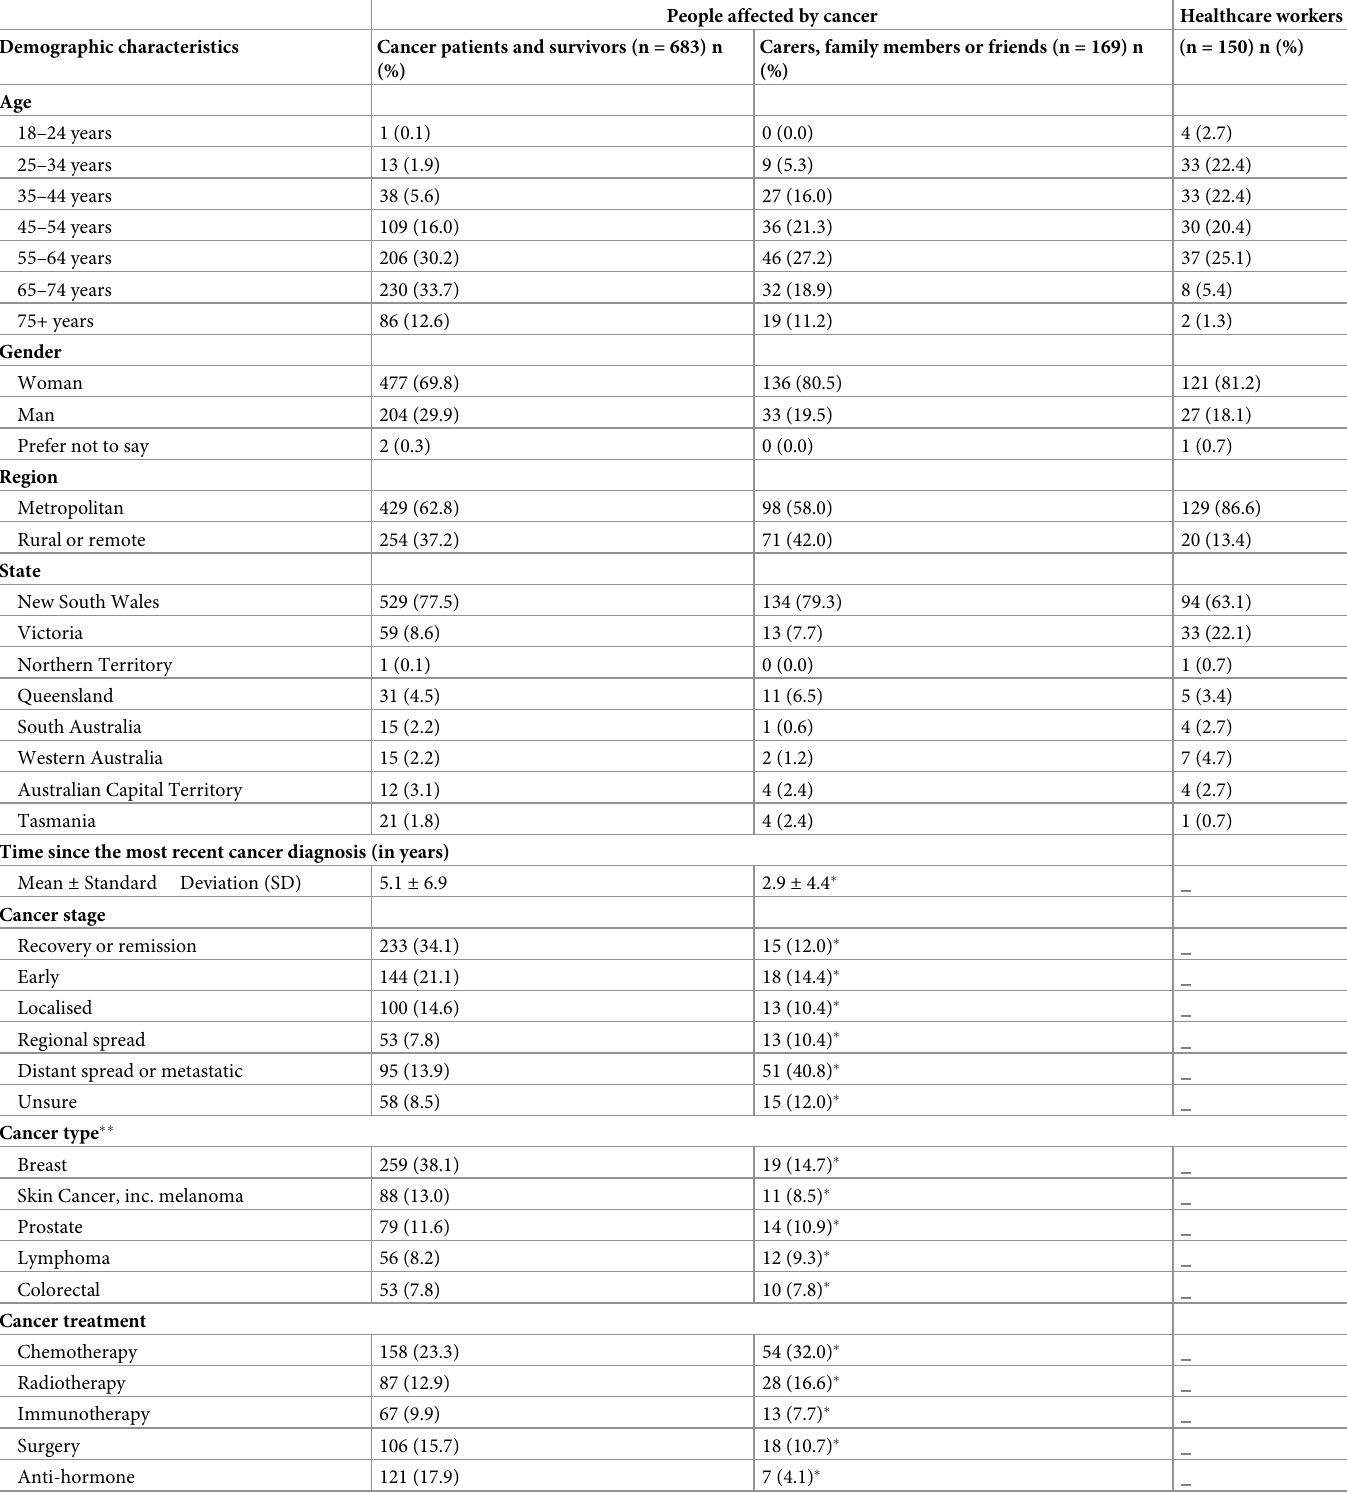
Table 1. Participants’